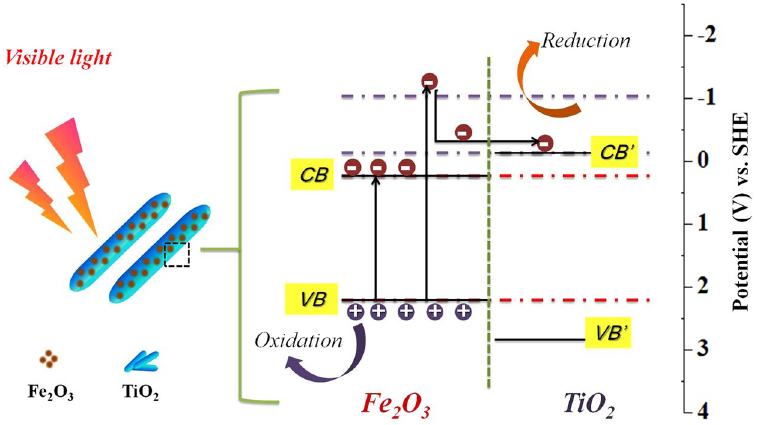
Figure 7. Possible mechanism of photocatalytic denitrogenation of pyridine over TiO 2 /Fe 2 O 3